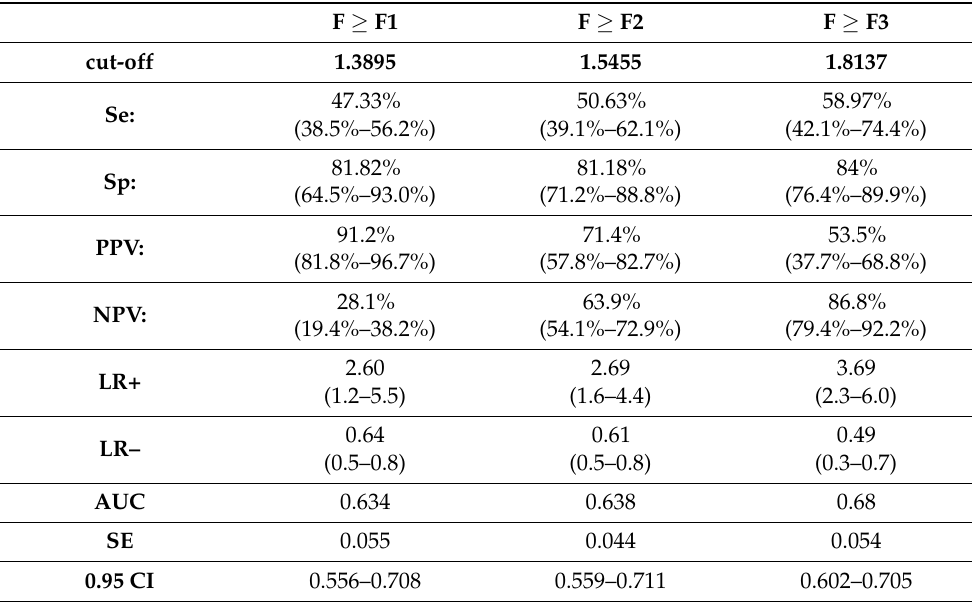
Table 8. The diagnostic performance of FIB-4 for fibrosis grades greater than or equal to 1, greater than or equal to 2, and greater than or equal to